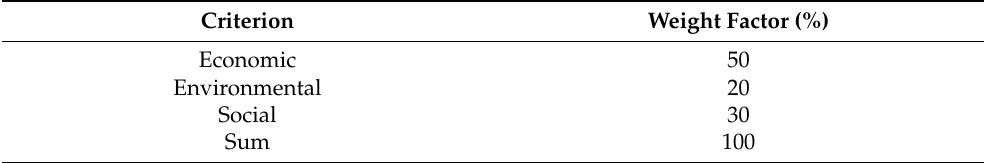
Table 3. Assumed weight factors for economic, environmental and social criterion of